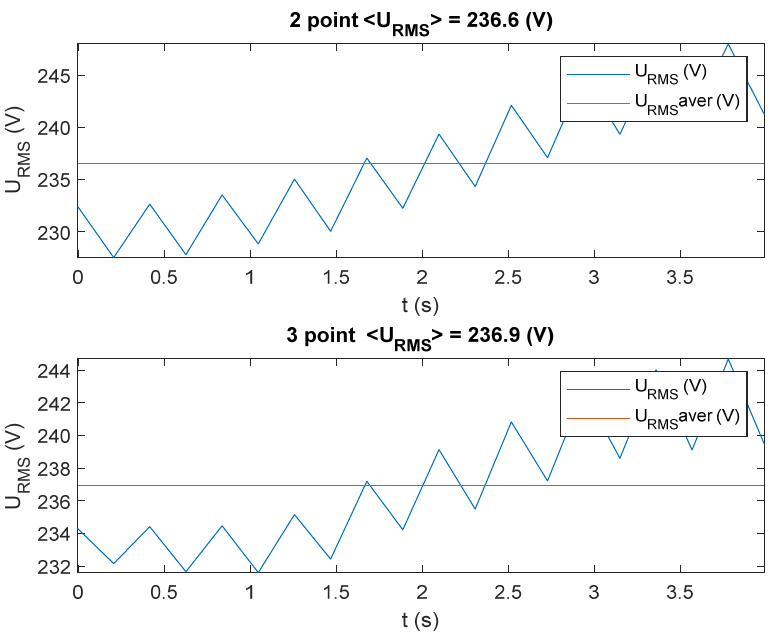
Figure 13. P measurement for the 1-st harmonic.